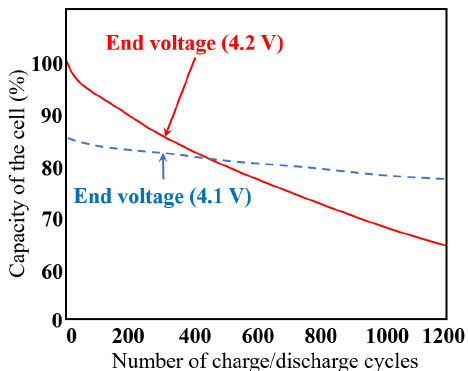
Figure 11. Extending battery life by lowering the end voltage value.